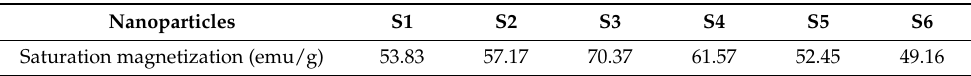
Figure 2. Magnetic hysteresis loops obtained at room temperature in the field range of − 2 T to +2 T for Fe 3 O 4 six sets of nanoparticles. Table 2. Mass normalized magnetization (M s ) values of six sets of Fe 3 O 4